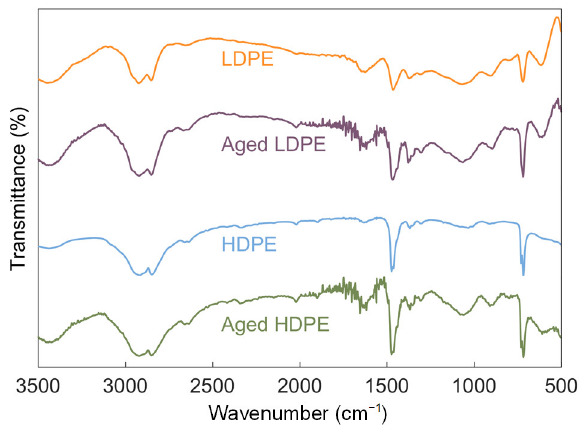
Figure 2. FTIR spectra of pristine and UV-weathered particulates of LDPE and HDPE.